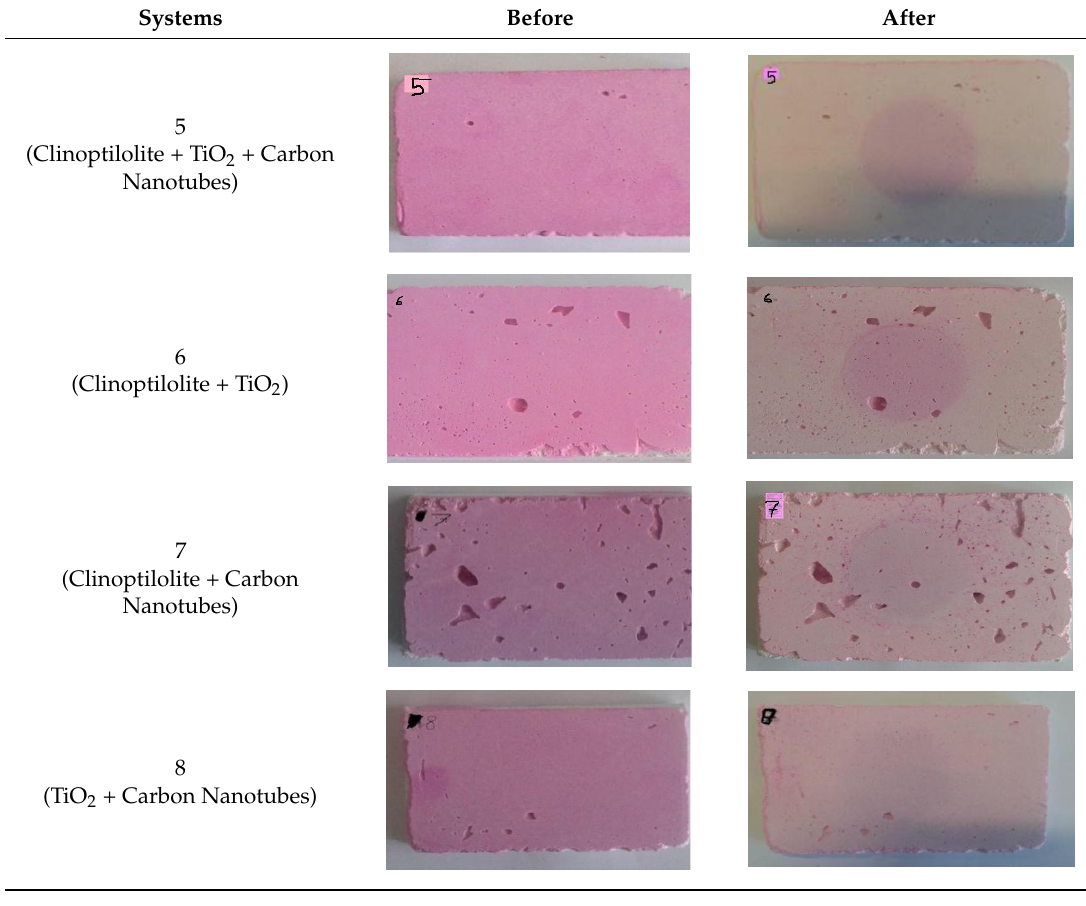
Table 7. Images of specimens before and after UV irradiation for a 3 h period.